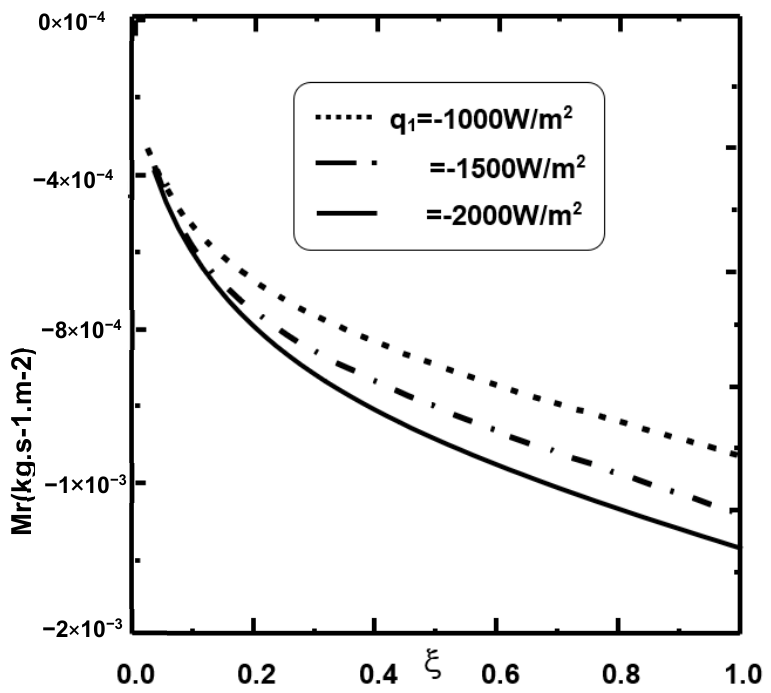
Figure 11. Effect of thermal flux cooling density on the cumulated condensation rate: T 0 =293.15 K, T 0L =293.15 K, T w =293.15 K, Φ 0 =0.03, c 0 =0.3, u 0 =1 m/s, m 0L =0.015 kg/m.s, H=1 m, d=0.015 m, p 0 =1 atm.